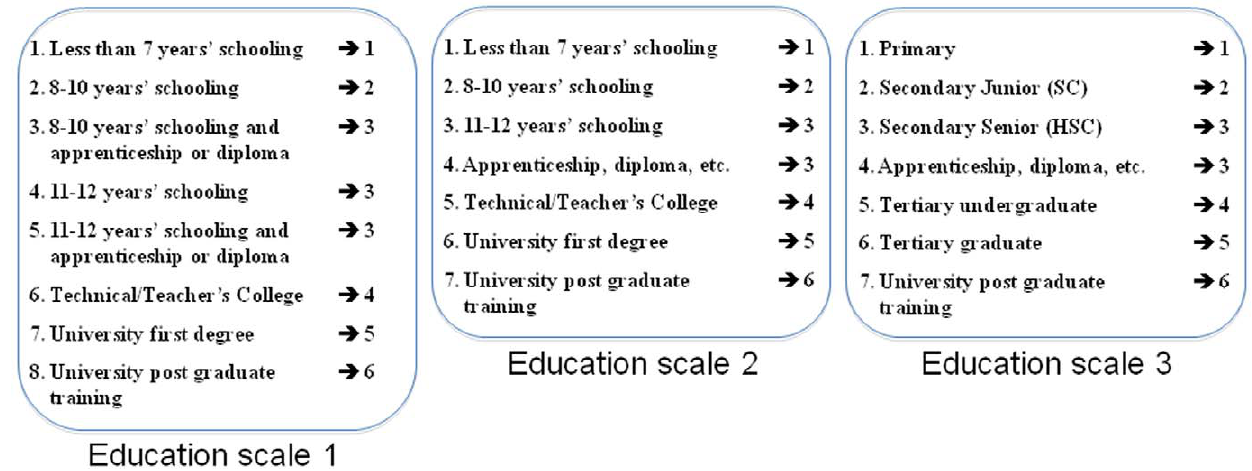
Figure 1. Transformation applied to the original education scales (1 to 3) to obtain a new harmonized scale across studies.